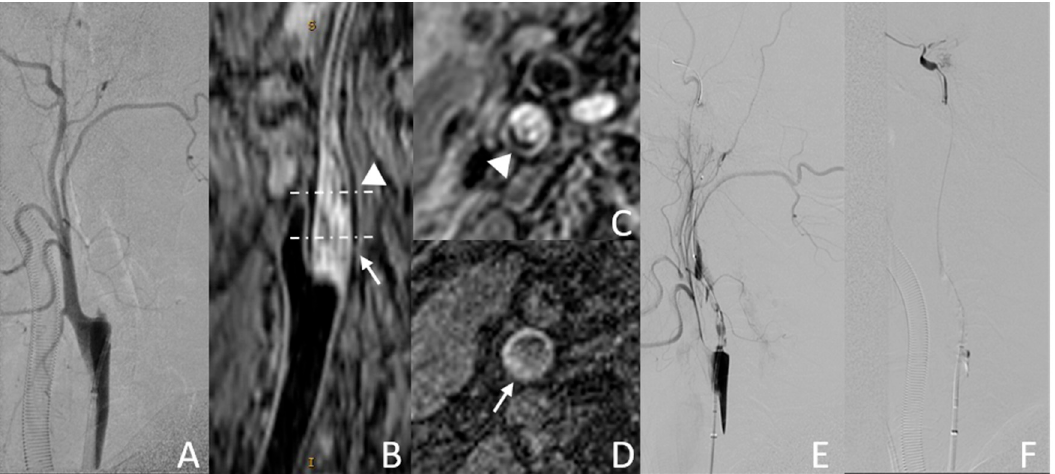
Table 4. Variables of the MR CICAO score.